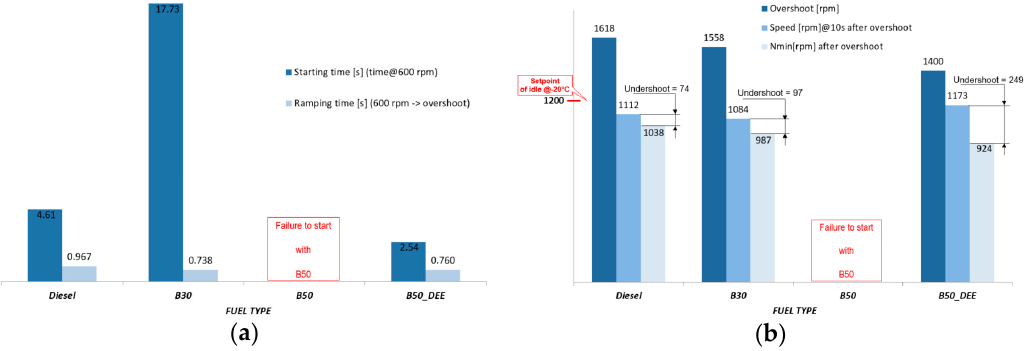
Figure 5. Speed-related parameters used to assess the engine cold starting performance: ( a ) speed evolution over time; ( b ) specific speeds.